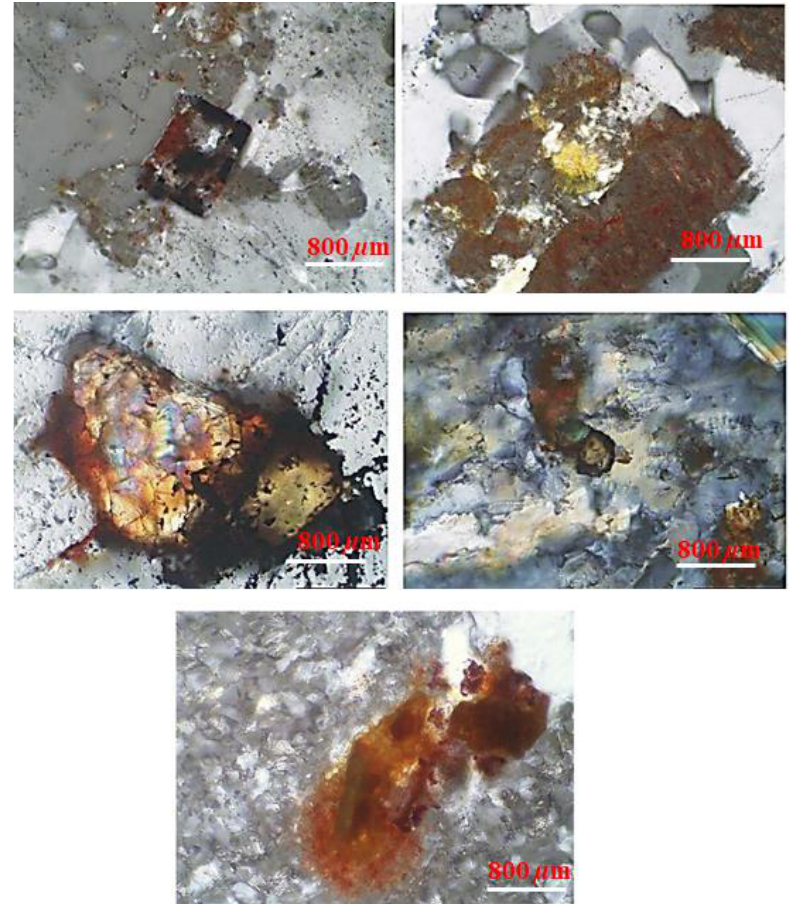
Figure 2. Photomicrographs showing uraninite, uranophane, thorianite, monazite, and columbite minerals in the Sol Hamed granite.